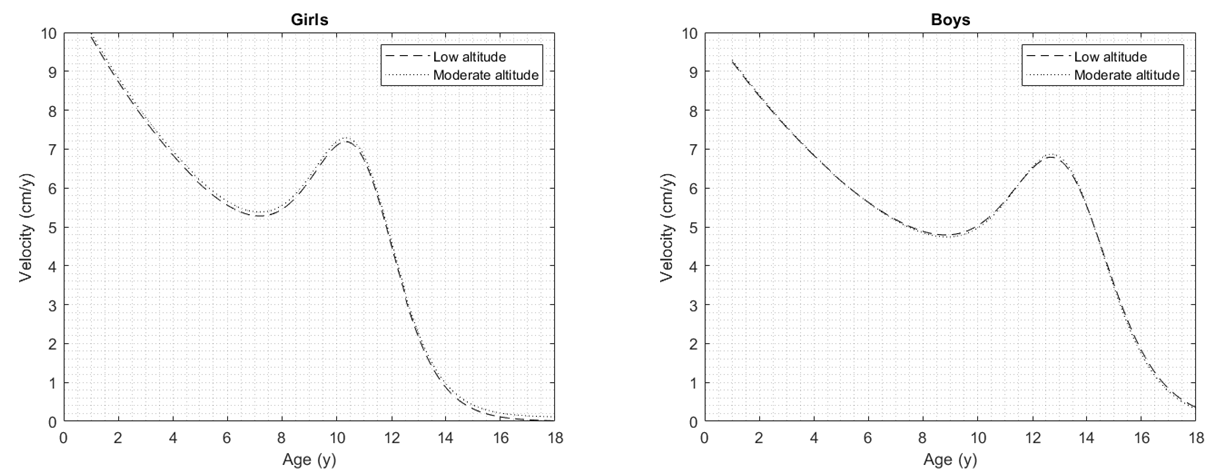
Figure 2. Comparison of the PHV curves of children and adolescents of both sexes living at low and moderate altitudes in Colombia.